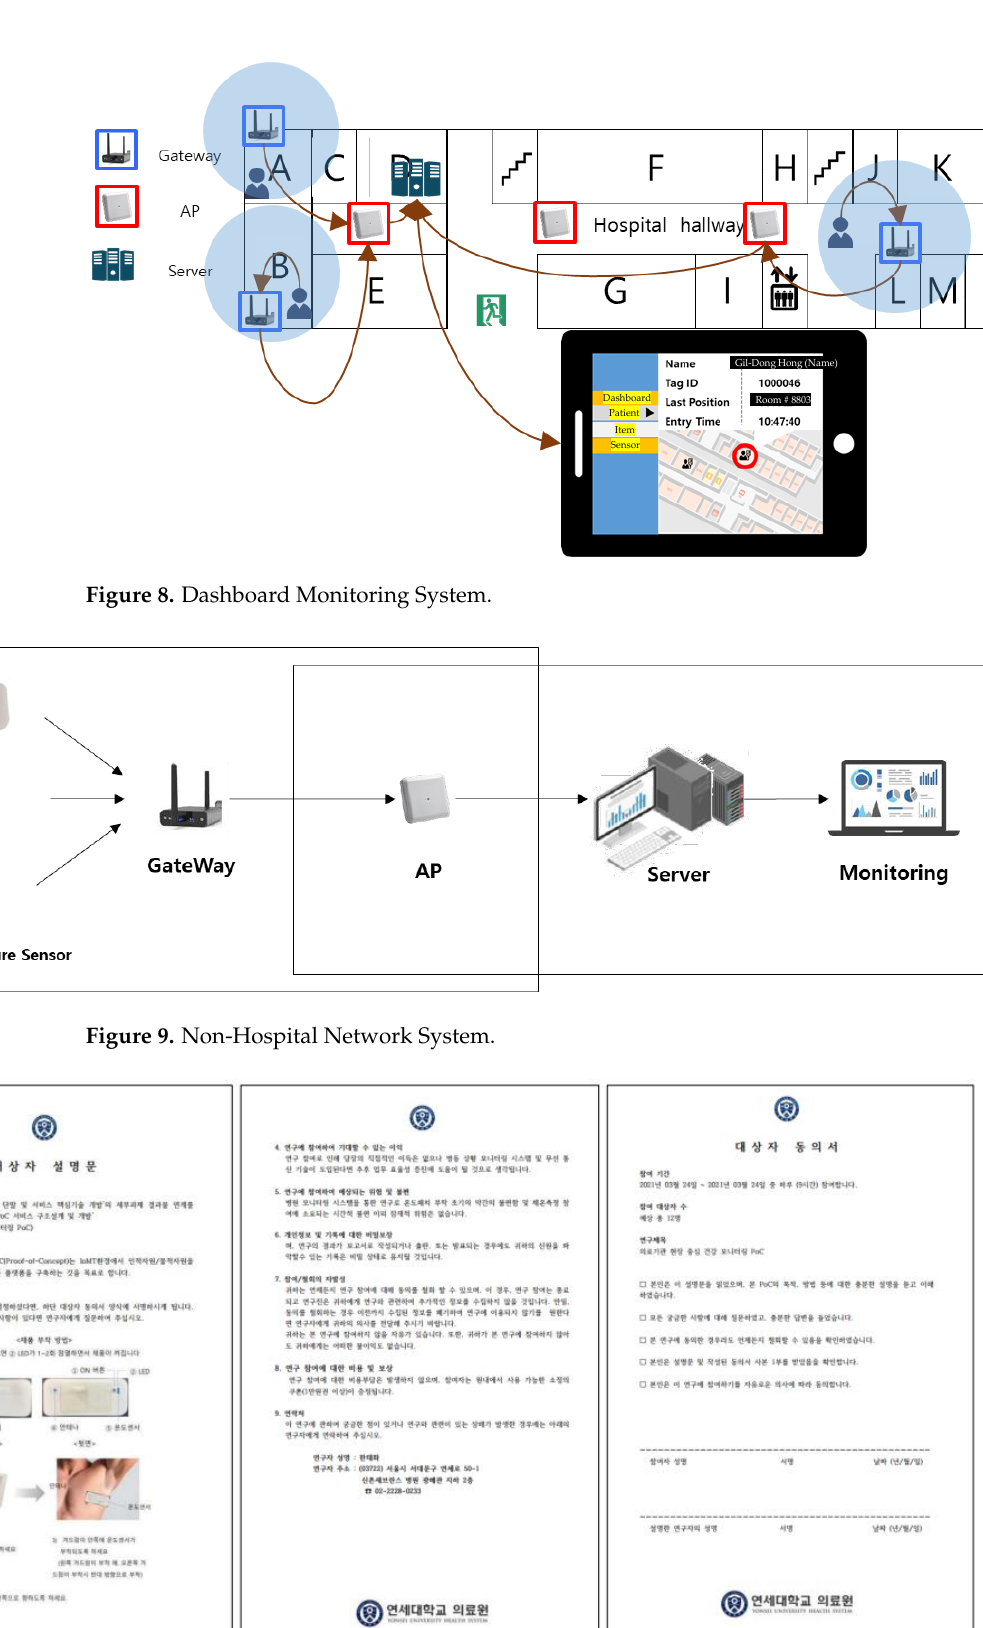
Figure 10. Participant Consent for Body Temperature Collection.